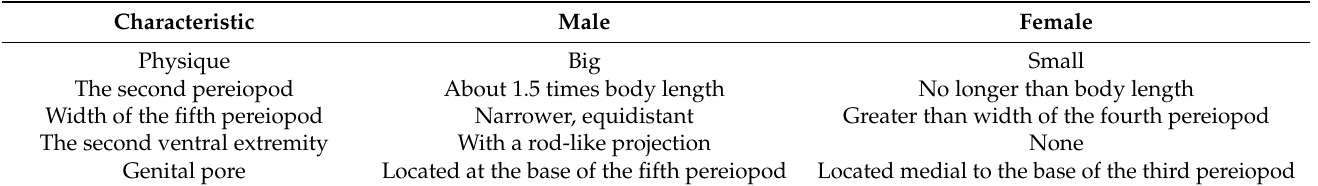
Table 2. Male and female appearance characteristics of oriental river